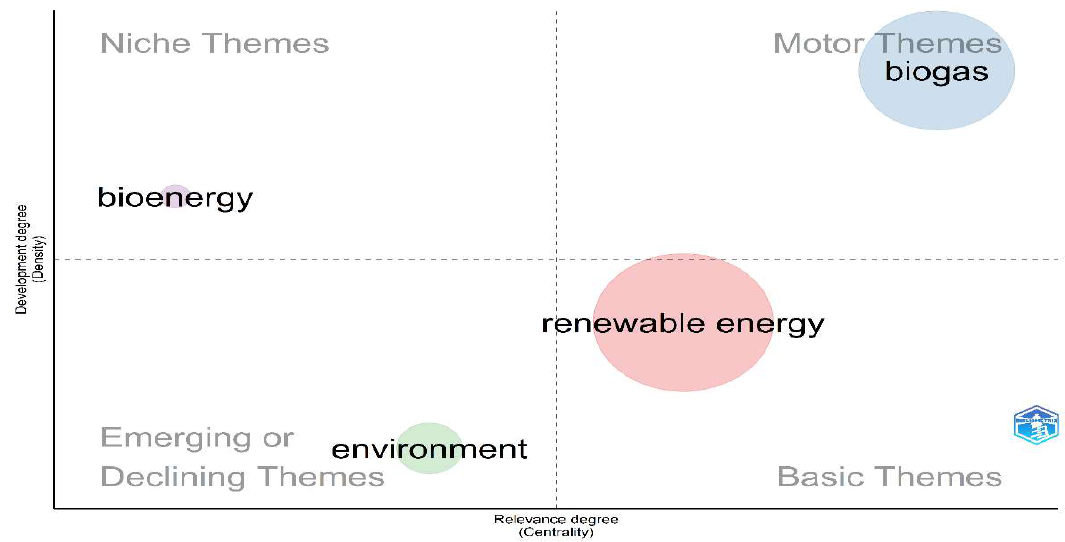
Figure 6. Thematic map (1988–2022). Source: created by the authors.